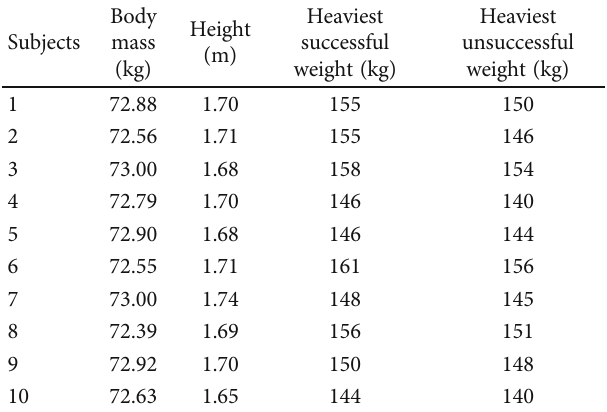
Table 1: Information of subjects ( n = 10